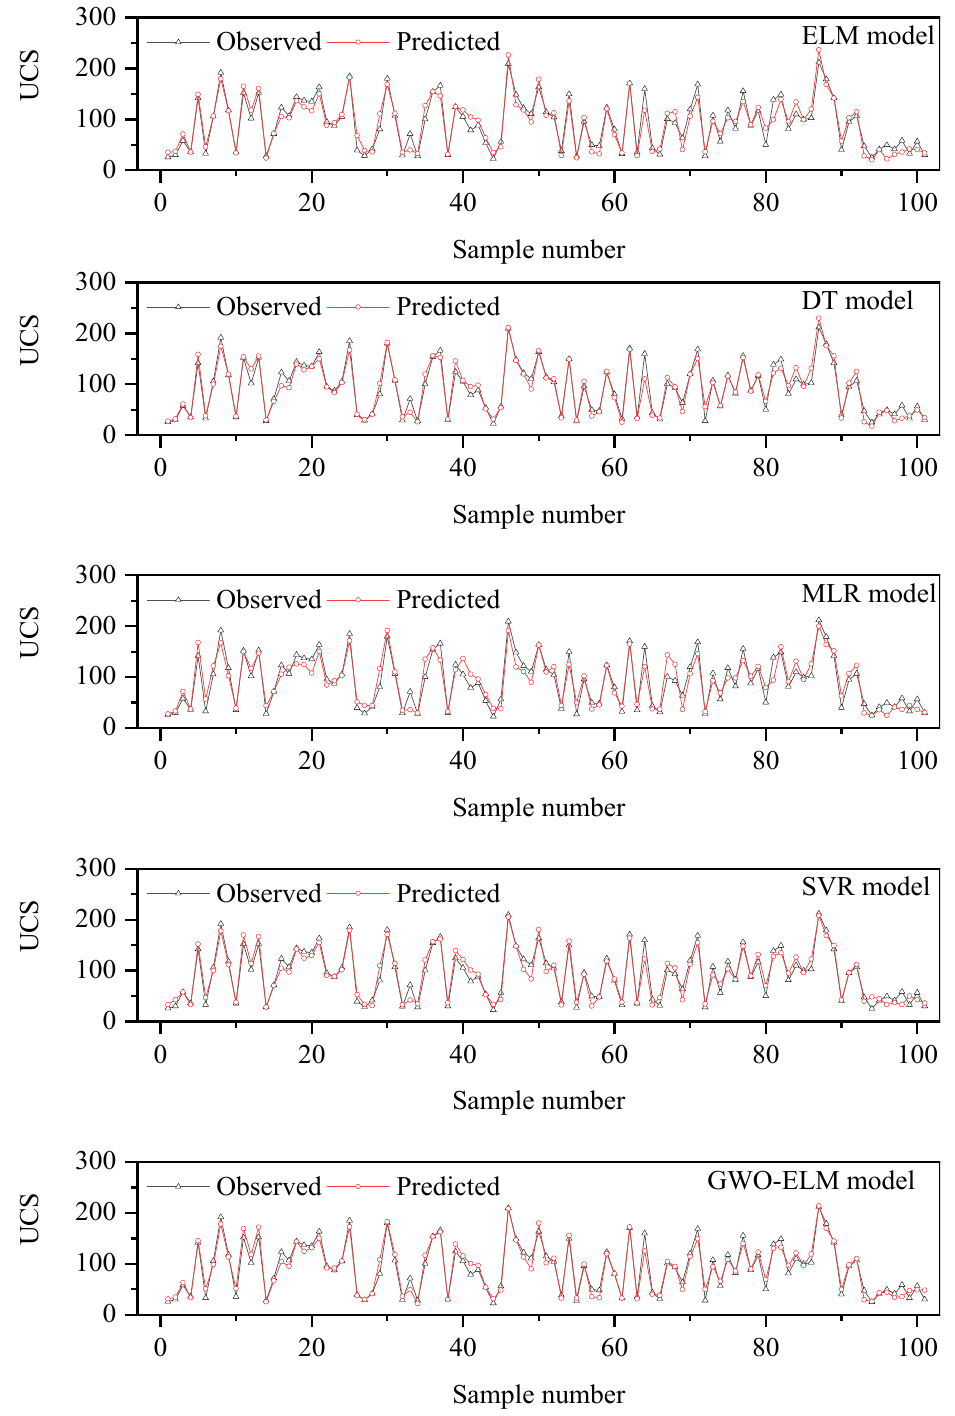
Figure 6. Comparison between prediction results and actual values of different models for UCS.